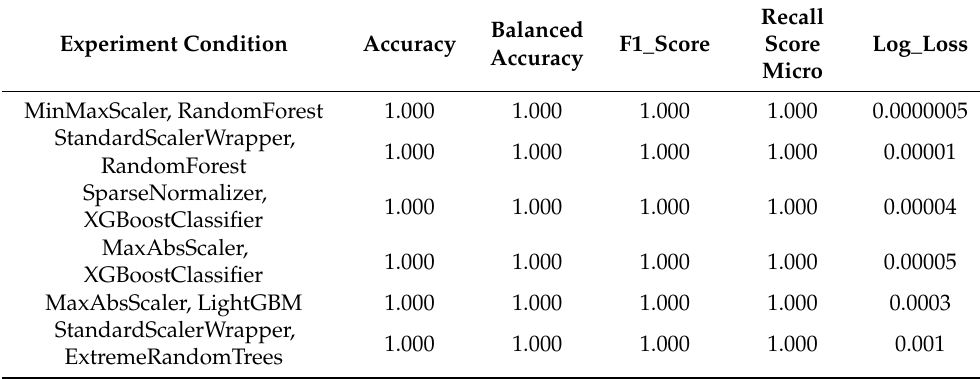
Table 2. ALD environment algorithm performance evaluation.